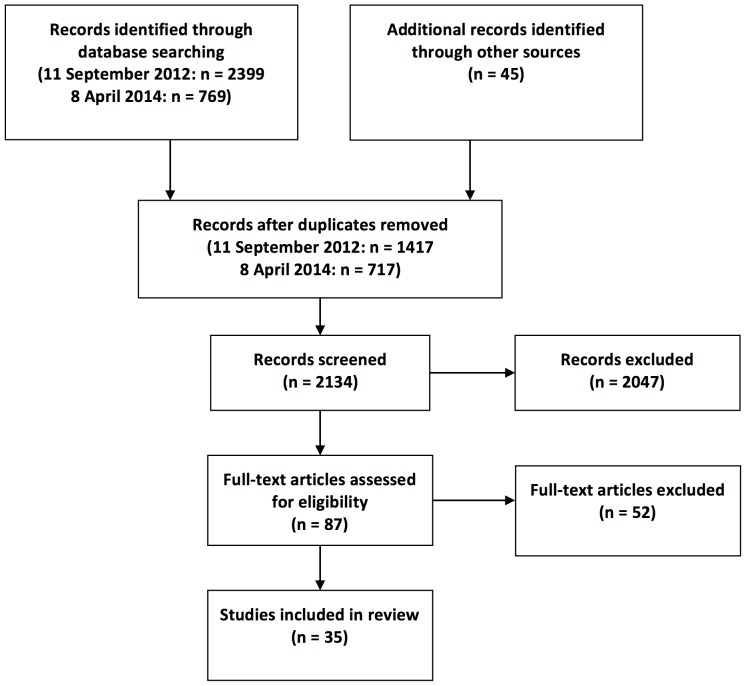
PRISMA Flow Diagram.